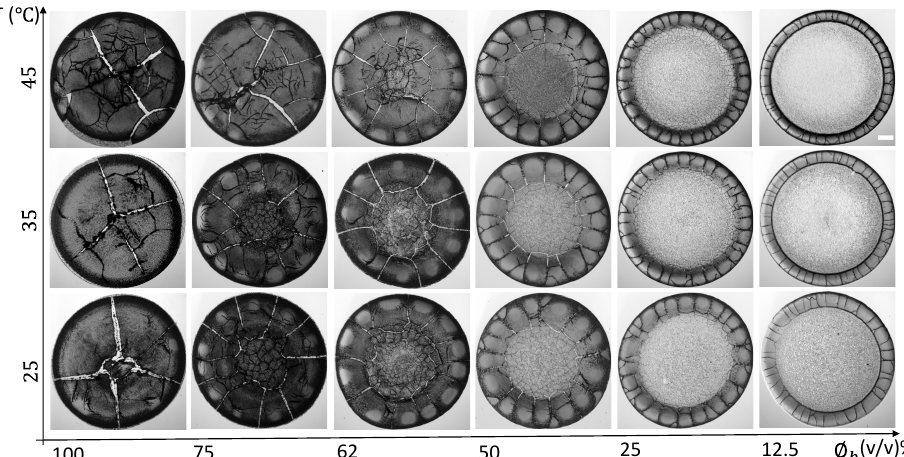
Figure 1. Morphology of the whole human blood film during 24 h at different initial concentrations ( φ b ) ranging from 100 to 12.5% ( v / v ) that are dried at various substrate temperatures (T) of 45, 35, and 25 ◦ C. The scale bar of length 0.2 mm is represented by the white rectangle in the top-right panel. The φ b of 100% ( v / v ) at T = 25 ◦ C has four radial cracks. These cracks divide the ring (or the corona) into large-sized domains (a similar behavior is observed in [1,19]).